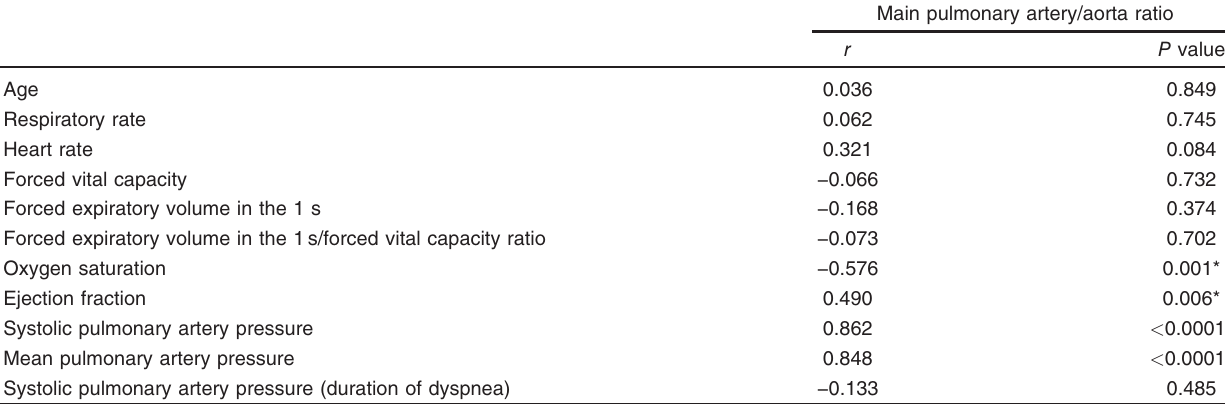
Table 6 Correlation between main pulmonary artery/aorta ratio, systolic pulmonary artery pressure ratio, and study parameters